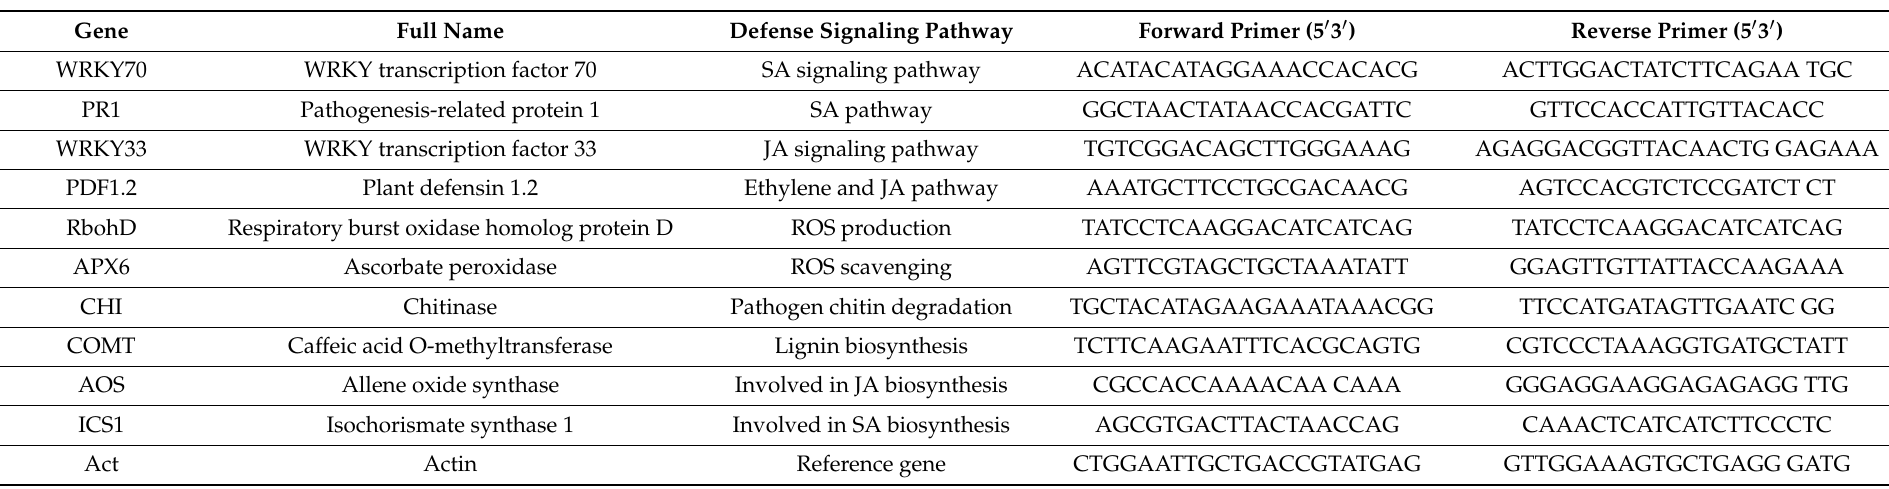
Table 2. List of selected defense-related genes in Brassica napus and their forward and reverse primers used for